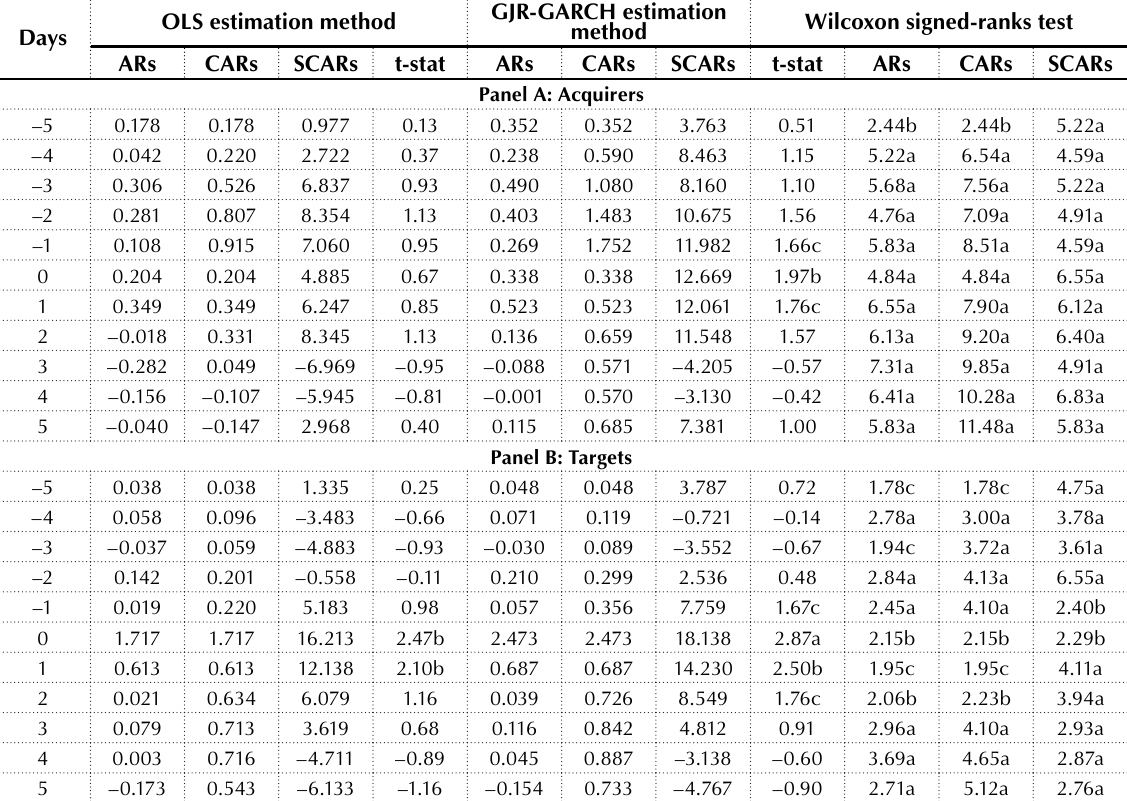
Table 2. Average AR measures for acquirers and targets around merger announcements using the four-factor CAPM under the OLS method and the GJR-GARCH method GJR-GARCH estimation OLS estimation method Days